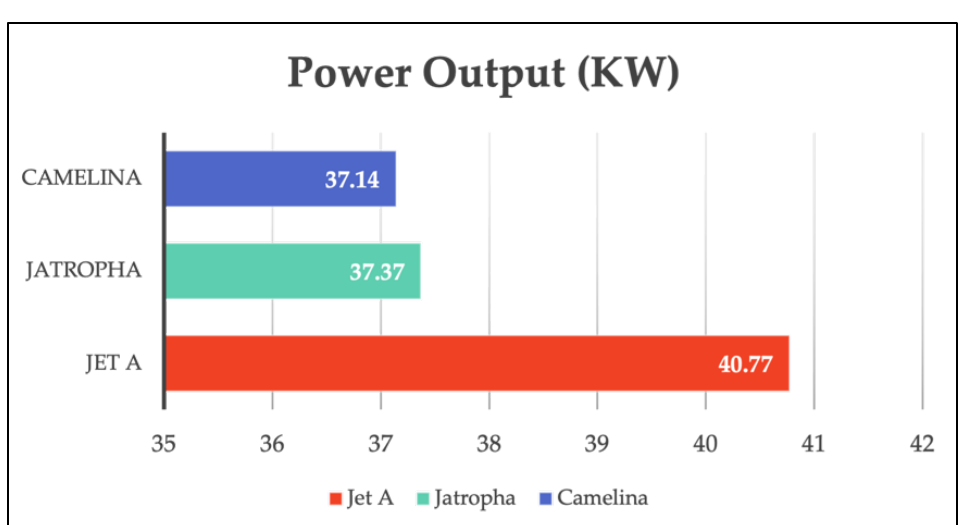
Figure 4. Power output comparison of the simulated fuels.